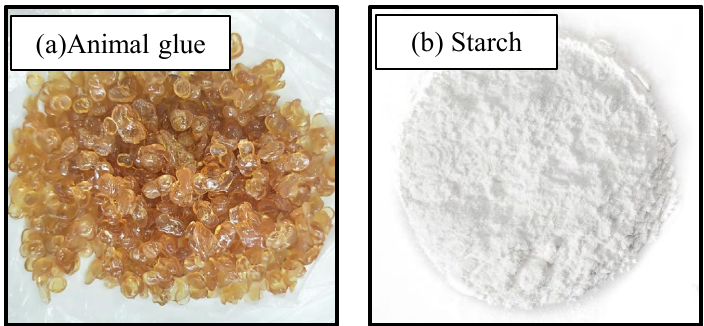
Figure 3. Optical photos of the animal glue ( a ) and starch ( b ).